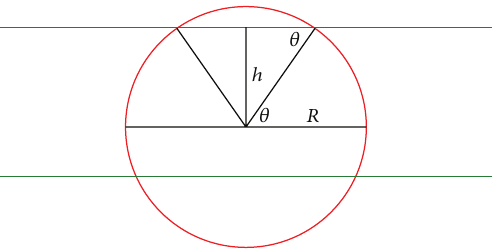
Figure 2: Calculating the fraction of the area of the rotor circle (red) contained between two pressure levels (green). In this example, the hub of the rotor lies between the pressure levels. The area above the hub is sum of two triangles and two sectors. The area of the triangles Figure1:Thecapacityfactor 𝐶 𝑓 ,thethrustcoefficient 𝐶 𝑡 ,andpower sum to ℎ√𝑅 2 − ℎ 2 . The area of the two sectors sum to 𝑅 2 sin −1 (ℎ/𝑅) coefficient 𝐶 𝑝 for the wind turbine parameterization configured to In this example, the area below the hub makes a similar positive = 4 , 𝑉 = 25 , model the Bonus Energy A/S 2 MW wind turbine. 𝑉 contribution. If the hub is not between the layers, the total area in out = 10 , 𝐶 = 0.158 , and 𝐶 = 0.87 . 𝛼 = 0.3 , 𝛽 = 1.18 × 10 −5 , 𝑉 is given by the subtraction of two areas calculated from the hub. 0 𝑡𝑠 𝑡𝑝 Likewise, if ℎ > 𝑅 , then ℎ is replaced by 𝑅 in the